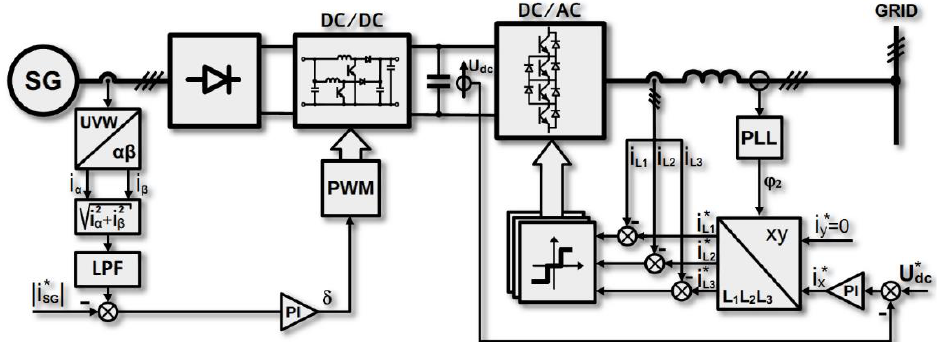
Figure 3. Converter control scheme — topology T2.